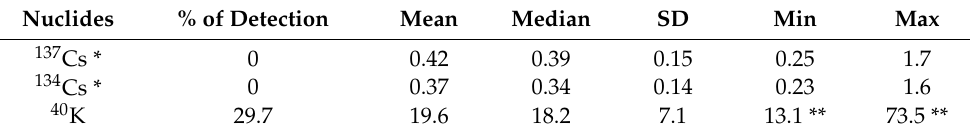
Table 2. Distribution of radionuclide levels (Bq/kg) in breast milk specimens ( n = 101). Nuclides